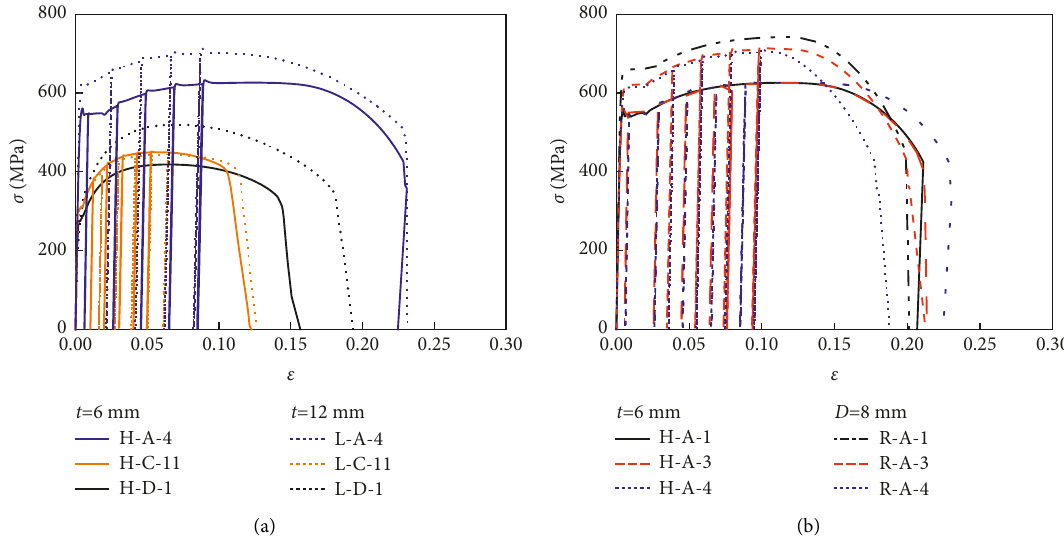
Figure 5: Stress-strain curves of material specimens. (a) Material specimens with different thicknesses. (b) Material specimens with different cross section shapes.